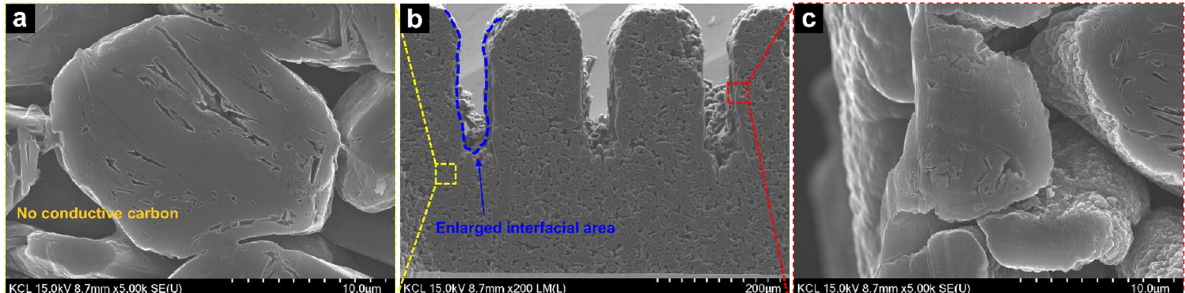
Figure 3. Cross-section SEM images of an original electrode at magnifications of ( a ) 200×, ( b ) 1000×, and ( c ) 5000×.